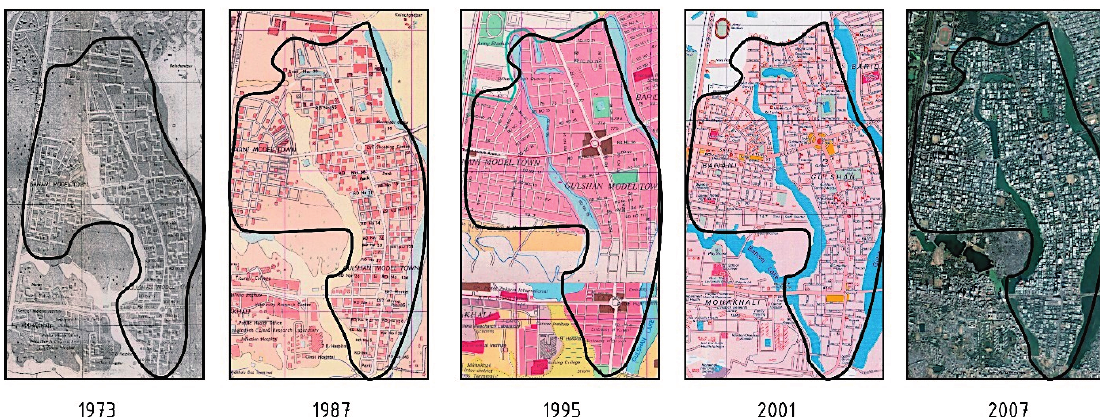
Figure A3 . Base maps of ward 19 (Gulshan) for syntactic analysis (not to scale). Source: Survey of Bangladesh and Google Earth Image, 2007.